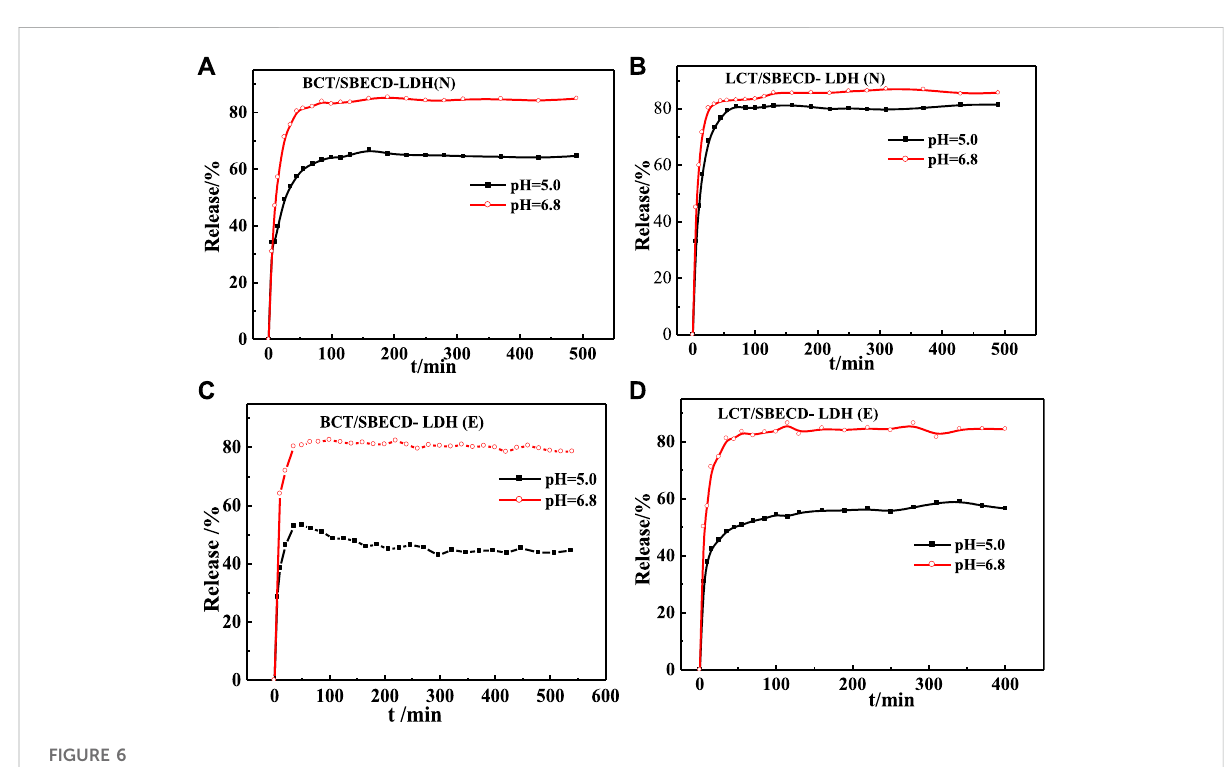
FIGURE 6 Release curves of pesticides from LDH-hybrids in different